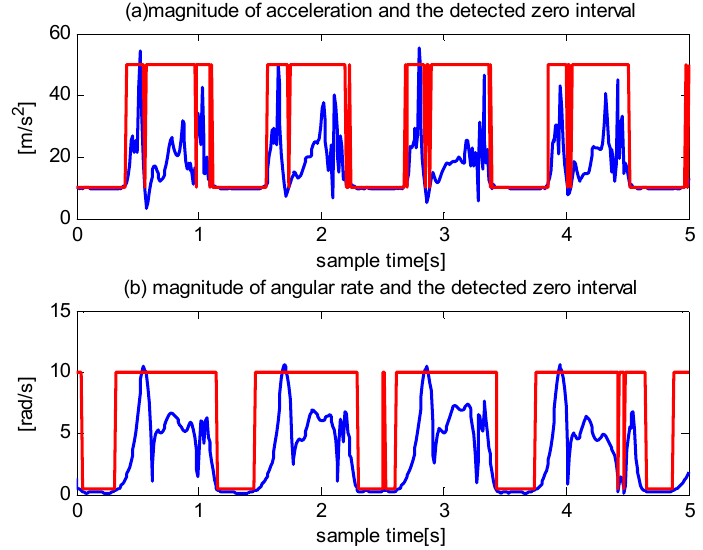
Figure 1. The detected zero velocity interval when a pedestrian is walking. The red line represents the stationary state and moving state. Small values indicate the stationary state. Large values indicate the moving state.